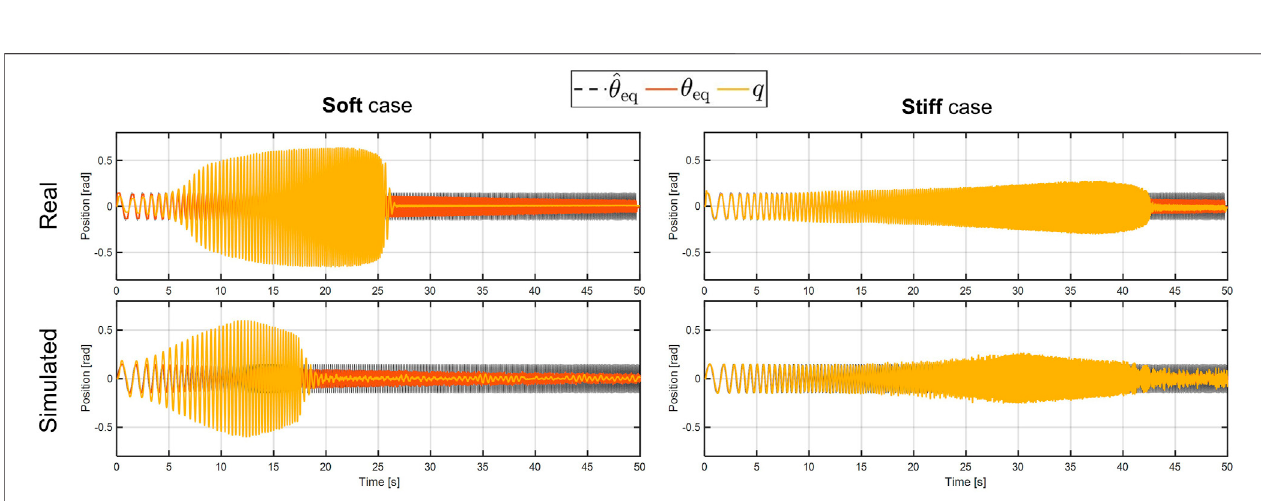
FIGURE 11 | Experimental (top plots) and simulated (bottom plots) results of the frequency response test. The left-hand side shows the soft behavior, while the stiff behavior is reported on the right-hand side.